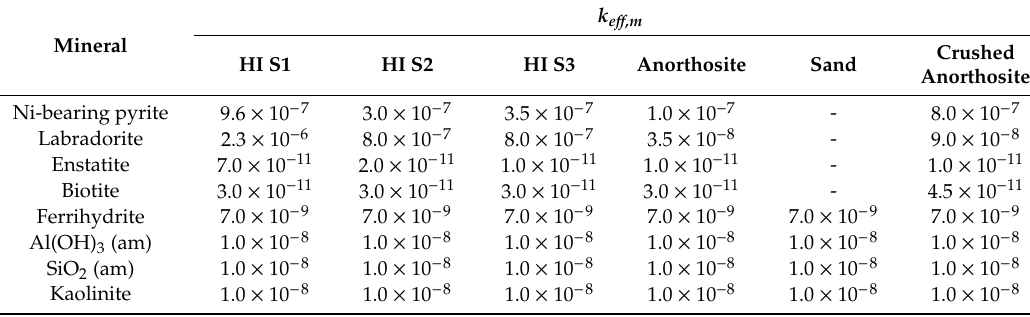
Table 6. Calibrated e ff ective rate coe ffi cients for the mineral weathering reactions (units in (mol dm − 3 bulk s − 1 ), except for pyrite, which is provided in units of (L H 2 O dm − 3 bulk s − 1 ); these units account for the scaling from pore volume to bulk volume for the first-order rate oxidation